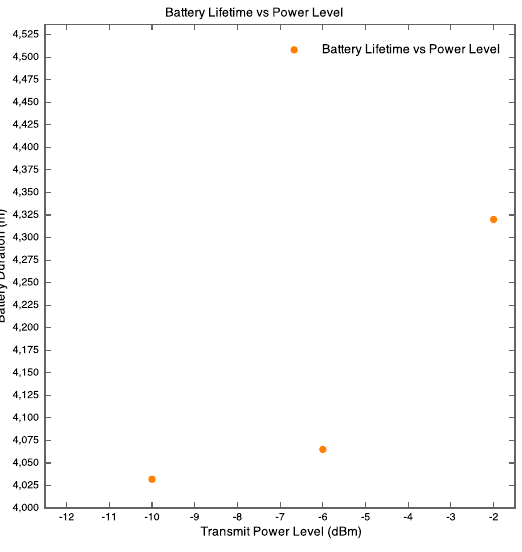
Figure 14. RSSI vs Time for different transmit powers for Experiment